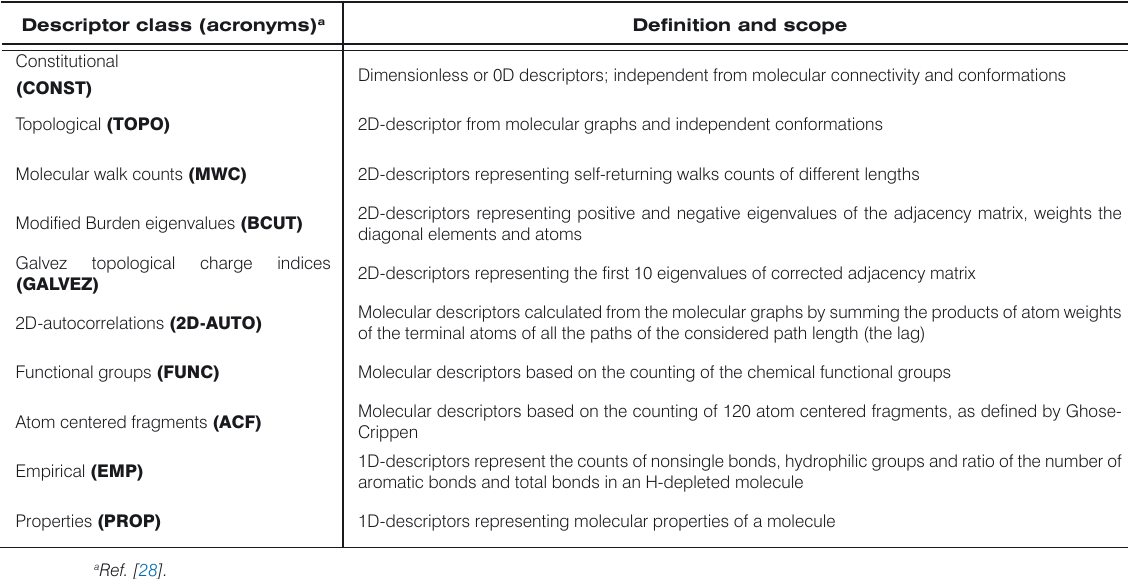
Table 3. Descriptor classes used for the analysis of derivatives of sulfonamide and sulfamate as the inhibitors of carbonic anhydrases, hCA I, hCA II and